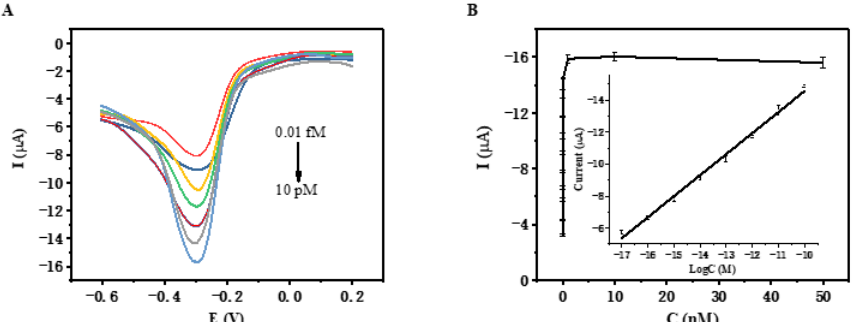
Figure 4. ( A ) Differential pulse voltammetry results of the fabricated biosensor to various CYP2C19*2 gene concentrations (0 fM, 0.01 fM, 0.1 fM, 1 fM, 10 fM, 100 fM, 1 pM, 10 pM, 100pM, respectively). ( B ) The resulting calibration plot of the peak currents versus the logarithm of CYP2C19 gene concentration in the range of 0.01 fM to 100 pM. The standard deviation of three parallel measurements is shown by the error bars.